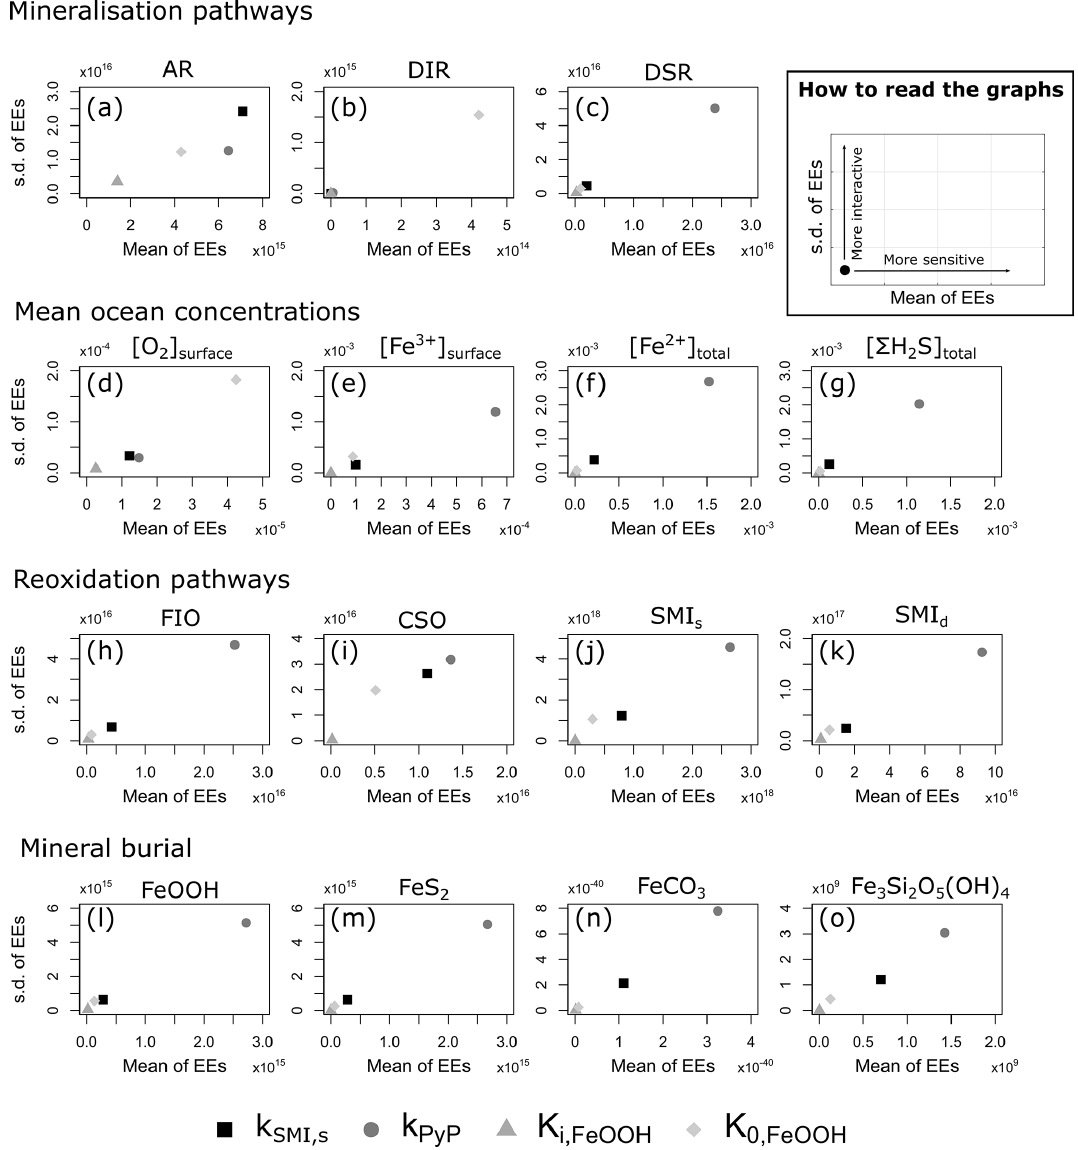
Figure 11. Sensitivity analysis of the four key parameters of the iron–sulfur cycle for a range of different outputs. Inset shows how to read the graph; points that plot more to the right indicate that the specific output is more sensitive to changes in parameter values, and points that plot higher indicate that the parameter is more interactive with other parameters. Data processing was done with the SAFE toolbox of Pianosi et al.